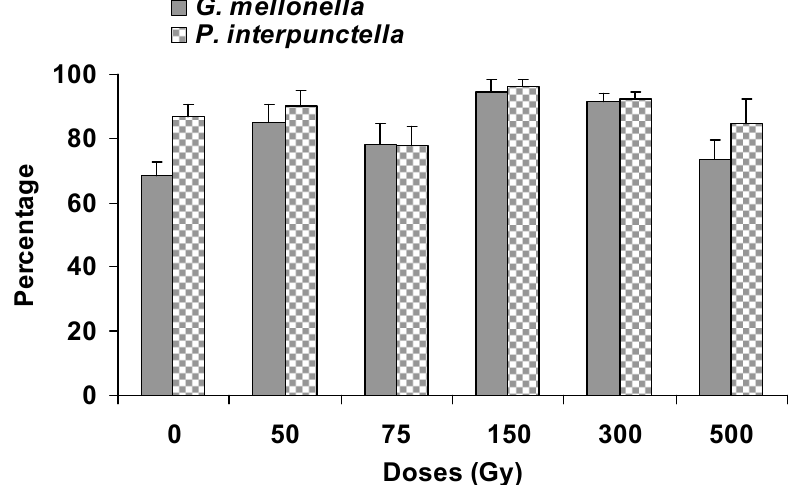
Figure 1. Percentage of parasitism (% ± SE) by H. hebetor developing from the gamma irradiated larvae of G. mellonella and P. interpunctella